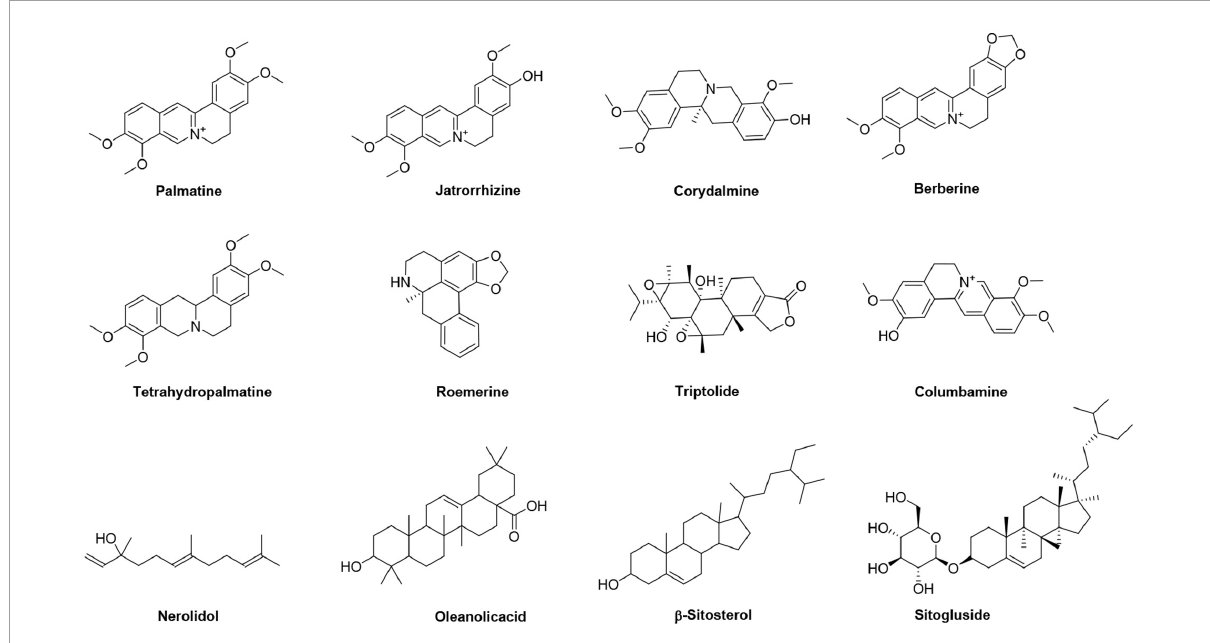
FIGURE2 Structures of the main ingredients from Fibraurea recisa Pierre .